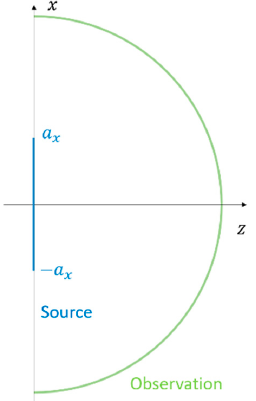
Figure 1. Linear source geometry.